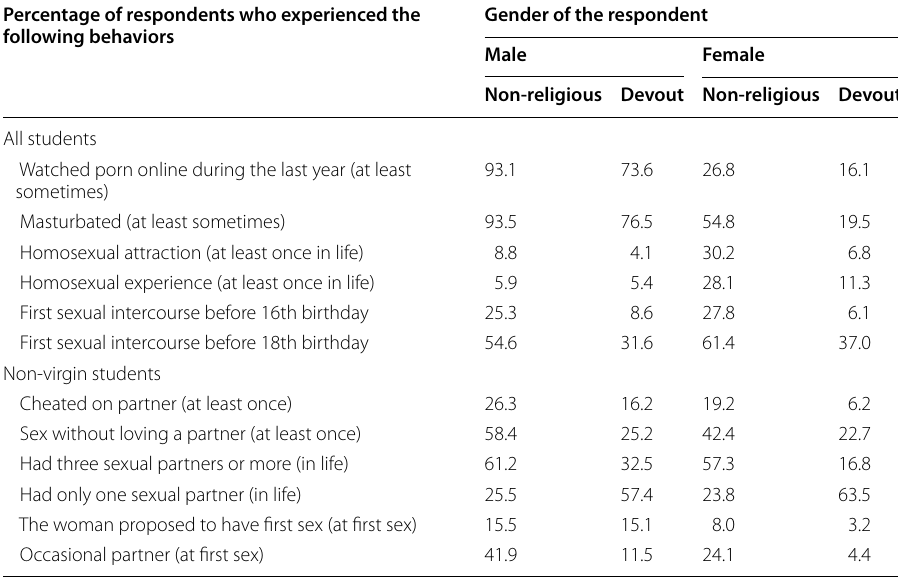
Source: authors’ elaboration on SIS and SELFY surveys data